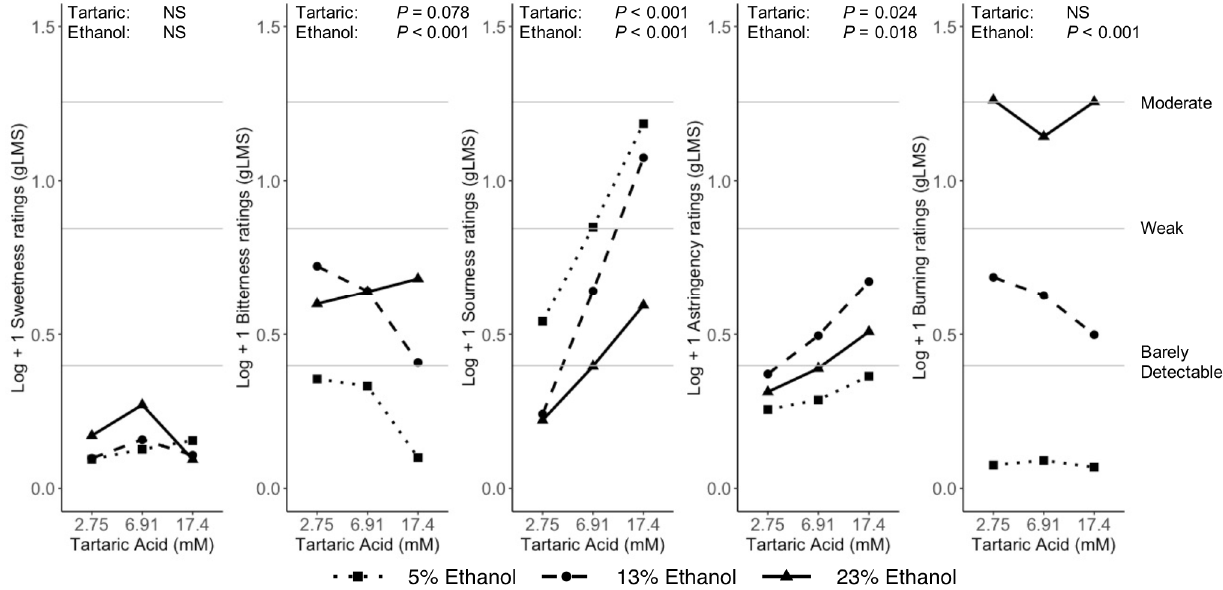
Figure 6. Mean ratings of sweetness, bitterness, sourness, astringency and burning/tingling in the binary solutions of ethanol (5%, 13%, 23% v/v ) and tartaric acid (2.75 mM, 6.91 mM, 17.4 mM). Significant differences are indicated from the p -values above each graph (NS = not significant). A full summary of the model including the effect of thermal taste status and 2-way interactions is included in Table S2.